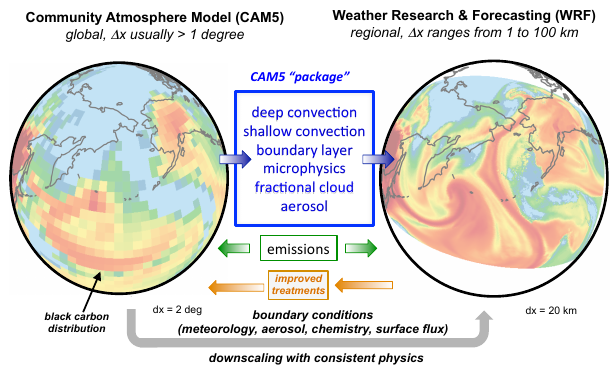
Fig. 1. Schematic diagram of the downscaling modeling framework with consistent physics between CAM5 and